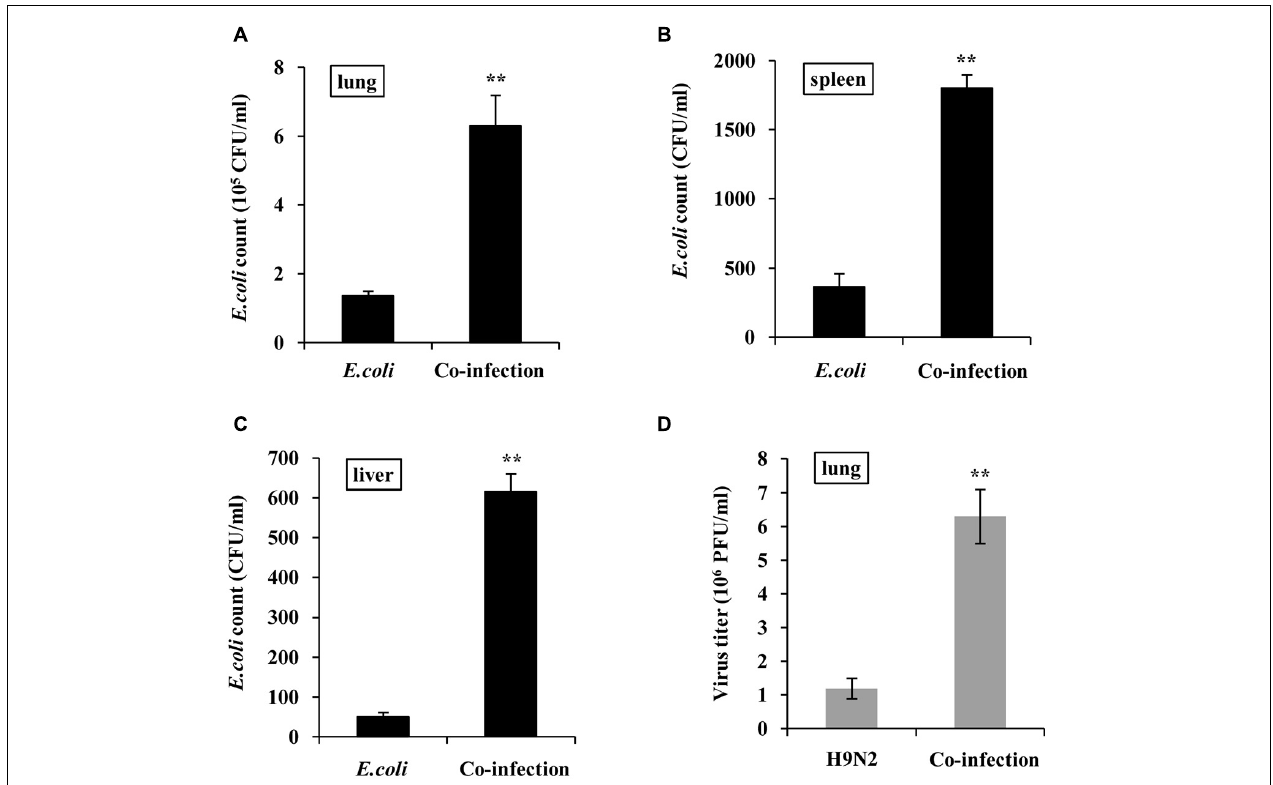
FIGURE 6 | H9N2 and E. coli loads are increased in co-infections. BALB/c mice were intranasally infected with single H9N2 AIV (1 × 10 4 PFU) and E. coli (1.5 × 10 7 CFU), or co-infected with H9N2 and E. coli for 48 h. (A–C) Bacterial loads in mouse lungs (A) , spleens (B) , and livers (C) were measured. (D) Virus titers in mouse lungs were determined by plaque assay. Data are presented as the mean ± SD of three independent experiments. ** P <